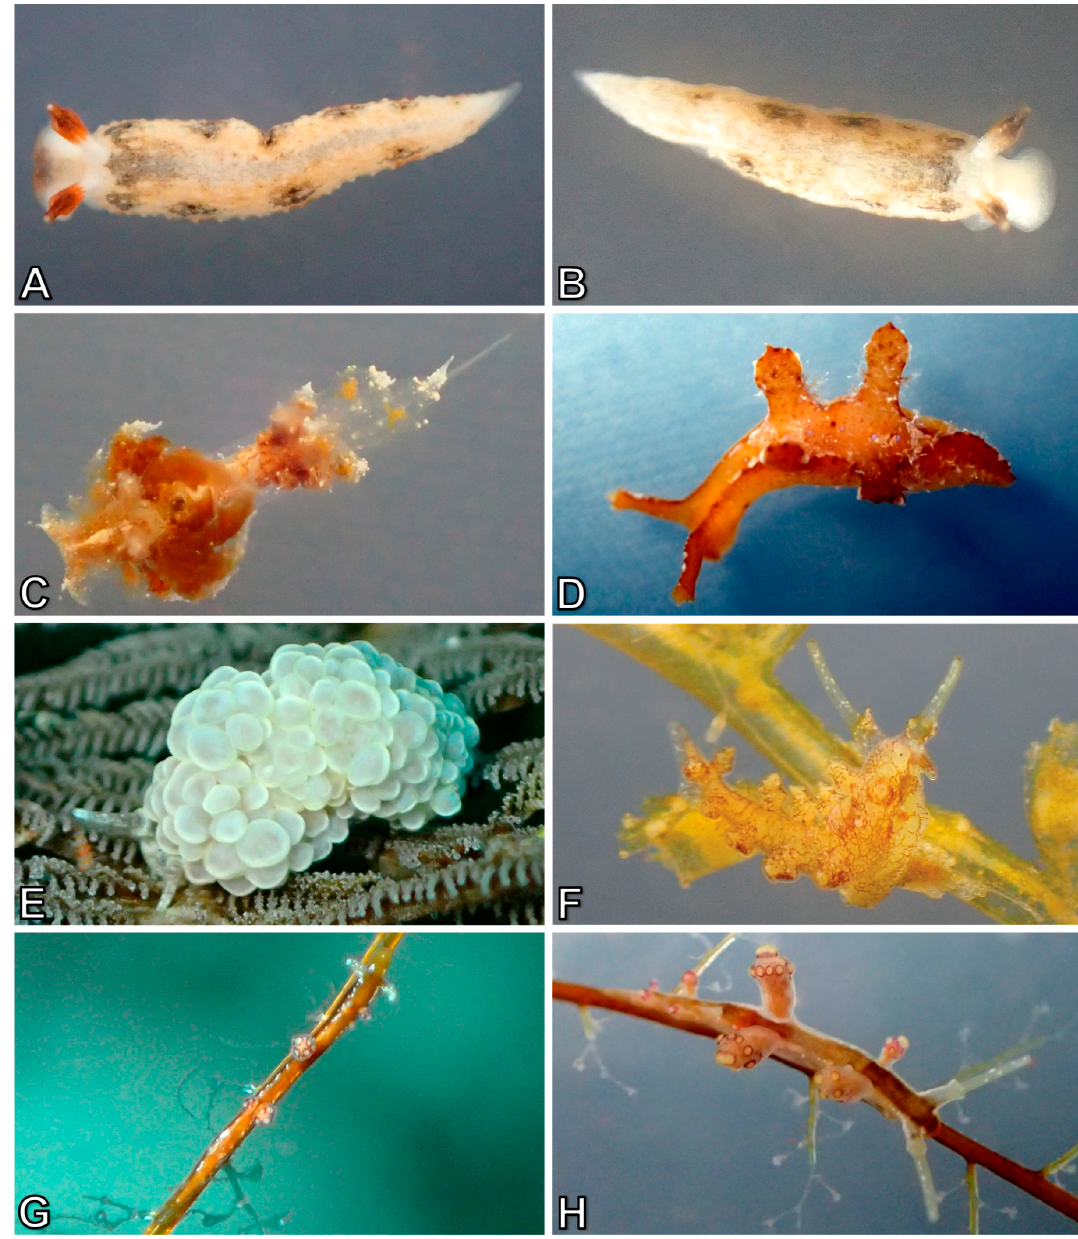
Figure 12. Nudibranchia - Cladobranchia: ( A ) Dermatobranchus cf. piperoides ; ( B ) Dermatobranchus spec., Desp1_16Bu-1; ( C ) Janolus cf. mirabilis ; ( D ) Crosslandia daedali ; ( E ) Doto ussi ; ( F ) Kabeiro rubroreticulata ; ( G ) Kabeiro spec.; ( H ) Kabeiro spec., Kasp16Bu-16.